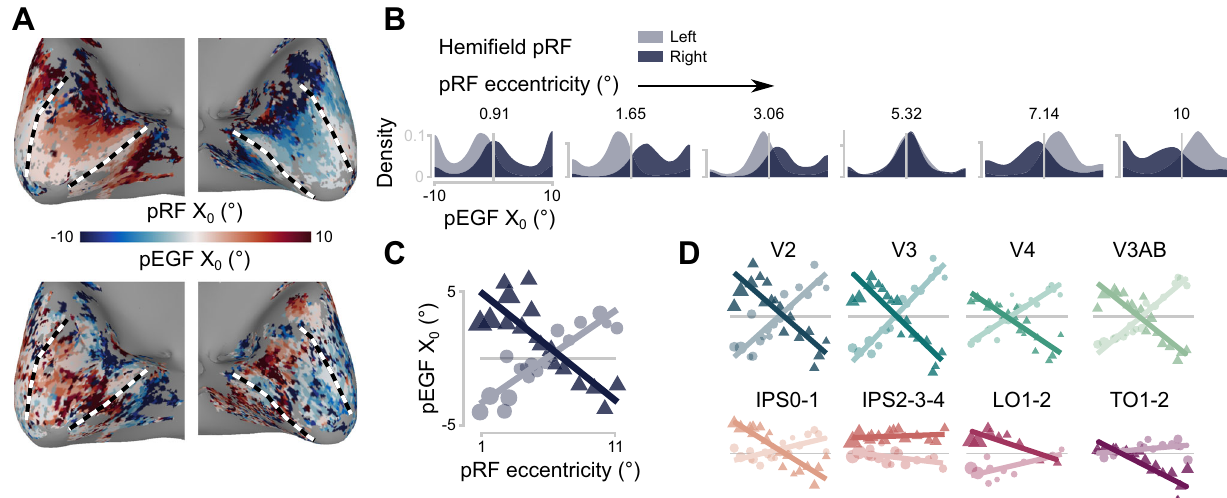
Fig. 5 | Coupling between pRF center and pEGFcenter. A Examplesurface maps of one participant. Black and white dashed lines mark the borders of V1. Top: horizontal component (X 0 ) of the pRF center, in degrees from the fovea. Bottom: X 0 ofpEGFcenter,indegreefrom fi xatingstraight ahead.See Figure S4forsurface maps of all participants. The pEGF X 0 shows a gradient from contralateral to ipsi- lateral along the posterior-anterior axis, the same direction as eccentricity of the pRFs. B Density distribution across all participants of pEGF X 0 binned for different pRF eccentricities in V1. Density estimates are split between pRFs in the left and right hemi fi eld. At pRF eccentricities lower than ~6°, pEGF centers are biased towardsthesideoftheaccompanyingpRF.AthigherpRFeccentricitiesthispattern